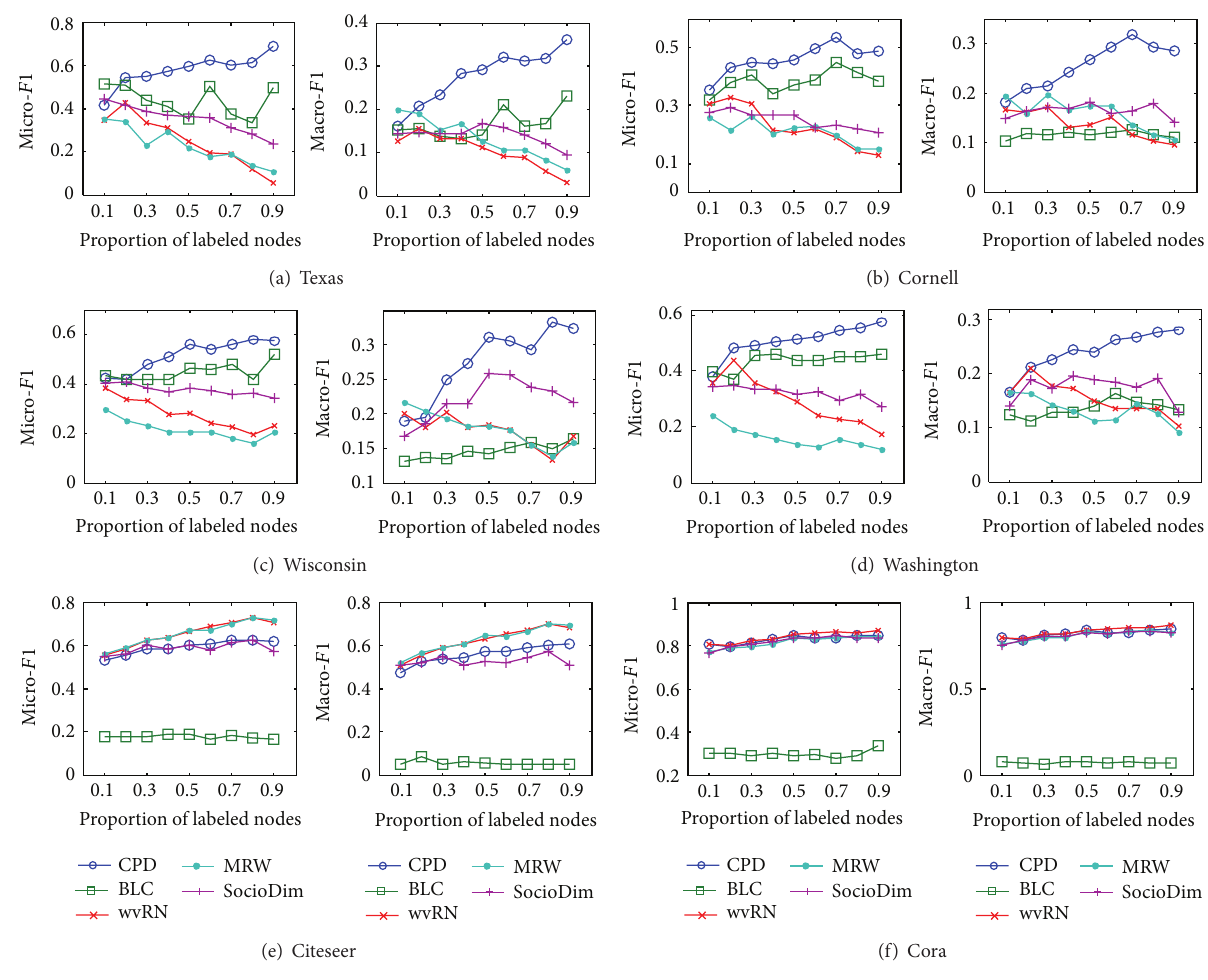
Figure 1: Results of comparison experiments.